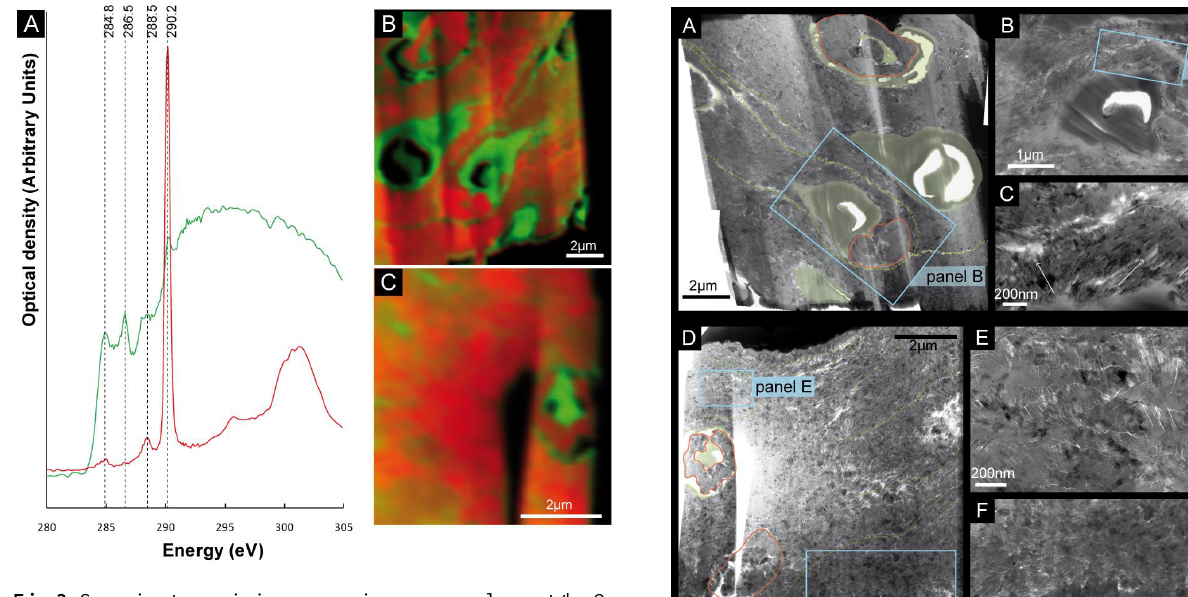
1 Fig. 3. Scanning transmission x-ray microscopy analyses at the C- Figure 3. Scanning transmission x-ray microscopy analyses at the C-Kedge of FIB foils A and 2 Kedge of FIB foils A and B (A) NEXAFS spectra at the C K-edge B (A) NEXAFS spectra at the C K-edge of organic matter composing the cells (green) and 3 of organic matter composing the cells (green) and carbonates (red). carbonates (red). (B) STXM map with 40 nm spatial resolution showing the distribution of 4 (B) STXM map with 40nm spatial resolution showing the distri- organic matter (green) and carbonate (red) in FIB foil A. Cell morphology is preserved in the 5 bution of organic matter (green) and carbonate (red) in FIB foil A. first steps of fossilization. (C) STXM map with 40 nm spatial resolution showing the 6 Cell morphology is preserved in the first steps of fossilization. (C) distribution of organic matter (green) and carbonate (red) in FIB foil B. The remnant of one 7 STXM map with 40nm spatial resolution showing the distribution cell can still be seen, whereas in its surroundings the organic matter is diffuse within 8 of organic matter (green) and carbonate (red) in FIB foil B. The aragonite. 9 remnant of one cell can still be seen, whereas in its surroundings, the organic matter is diffuse within aragonite.